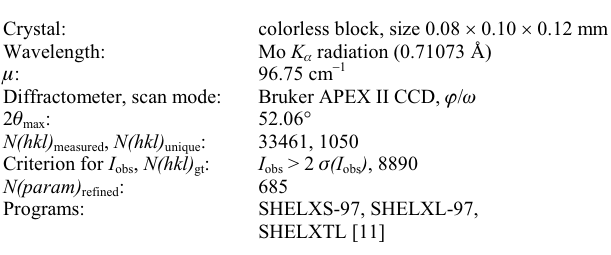
Table 1. Data collection and handling.